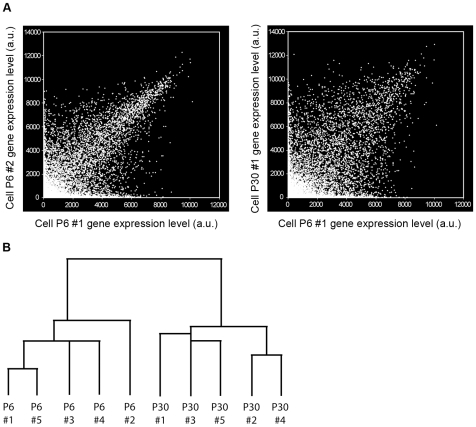
Single cell RT-PCR of individual Bergmann glia is sufficiently accurate for comparison of expression profiles by age.
A, Scatter plots of raw gene expression level compared between two cells from the same age (P6-1 vs. P6-2; left panel) and between ages (P6-1 vs. P30-1; right panel) (a.u.: arbitrary units). The samples from the same age show high similarity (mean within-age correlation coefficient = 0.81), which is comparable to what is reported between individual cells of a glioblastoma cell line (0.86) [25]. The high level of concordance between samples of the same age increases the reliability of comparisons between ages. Samples of different ages are significantly more divergent (mean P6 vs. P30 correlation coefficient = 0.66). B, Dendrogram and sample clustering of individual Bergmann glia. Unsupervised hierarchical clustering based on overall gene expression profiles reveals two distinct clusters corresponding to the two ages, P6 and P30. This suggests that the samples from the two ages do indeed represent two statistically distinct populations suitable for valid comparison.